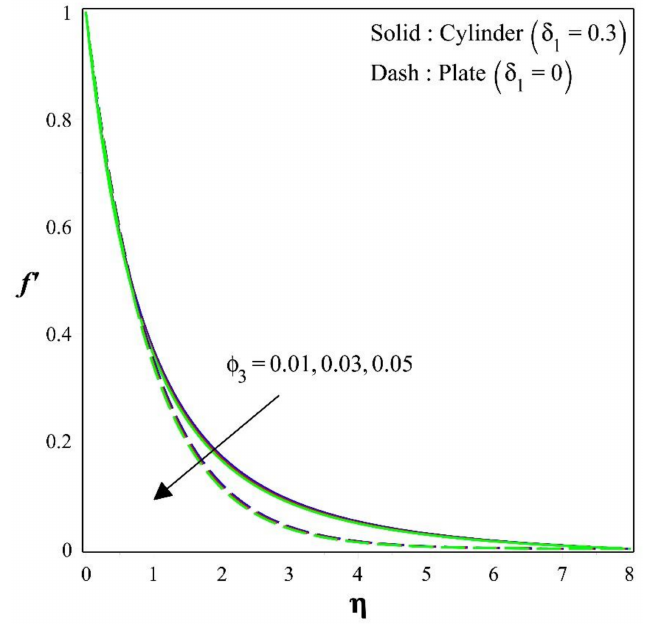
Figure 9. The role of solid volume fraction on velocity profile (keeping P m = γ 1 = 0.1, ζ = 30 0 , φ 1 = φ 2 = 0.01 & H SS =